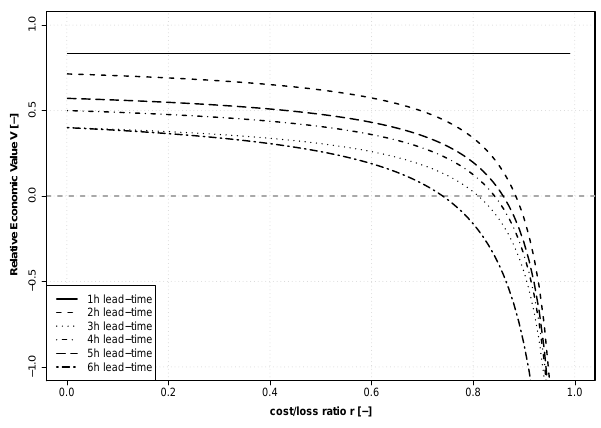
Fig. 6. Relative economic value as a function of cost-loss ratio and lead-time in the Deterministic Forecasts case.